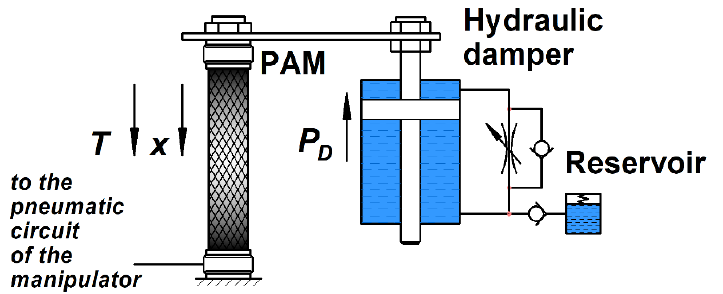
Figure 7. The scheme of PAM-based drive with hydraulic damper.